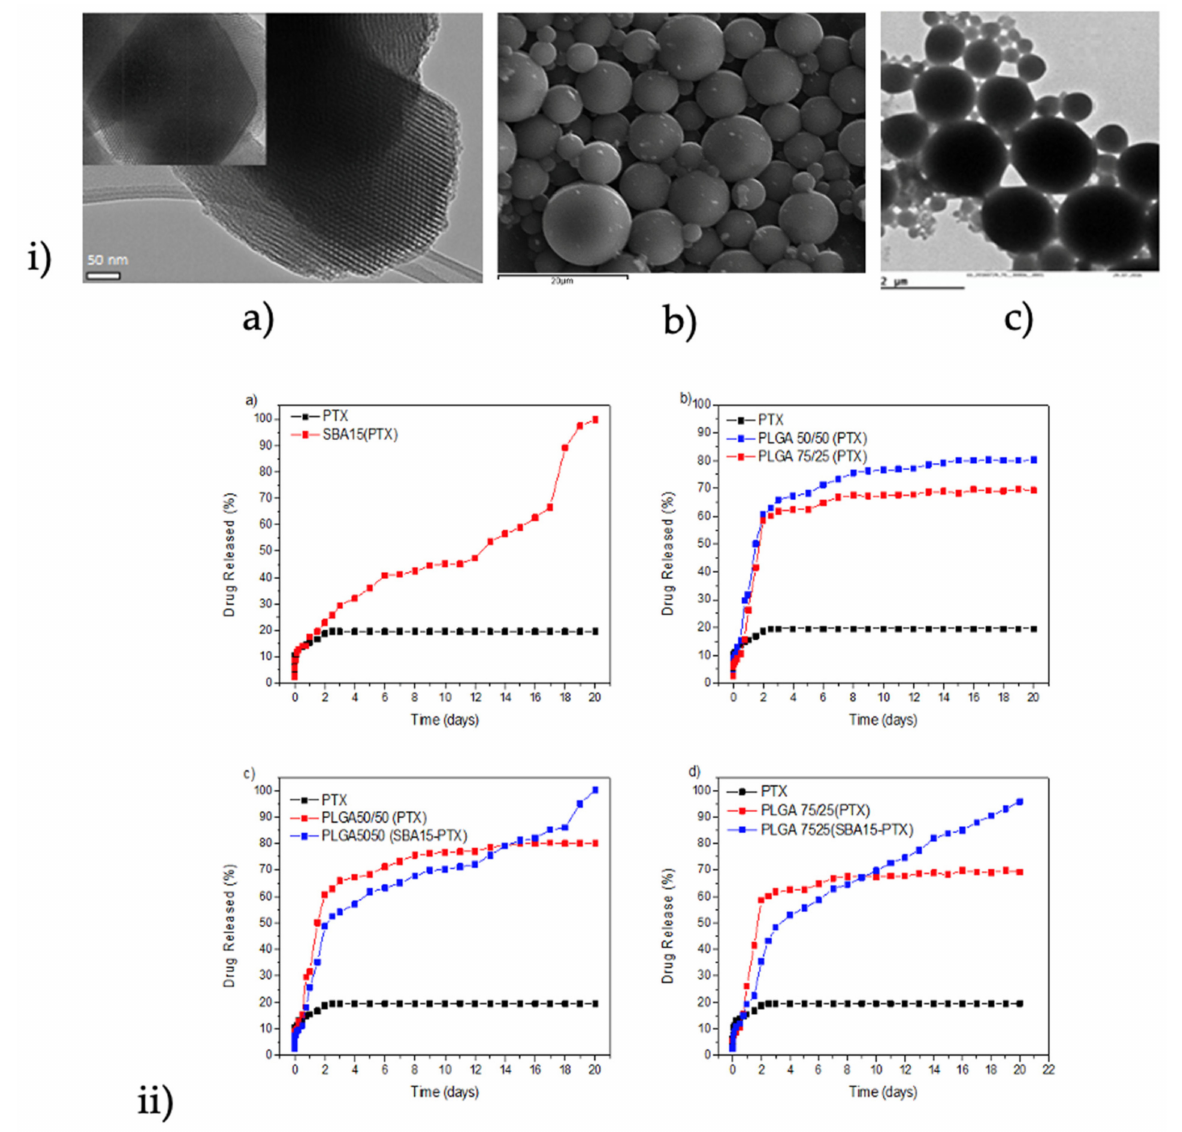
Figure 13. ( i ): ( a ) TEM micrographs of the parent SBA-15 mesoporous silica ( b ) SEM micrographs of PLGA 50/50 w/w microparticles ( c ) TEM micrographs of PLGA 50/50 w/w microparticles loaded with PTX/SBA-15, low magnification ( ii ) in vitro release of PTX ( a ) from SBA-15, ( b ) PLGA 50/50 and 75/25 w/w , ( c ) PLGA 50/50 w/w , PLGA 50/50 w/w loaded PTX/SBA-15, and ( d ) PLGA 75/25 w/w , PLGA 75/25 w/w loaded PTX/SBA-15. Adapted with permission from ref. [92]. 2021,